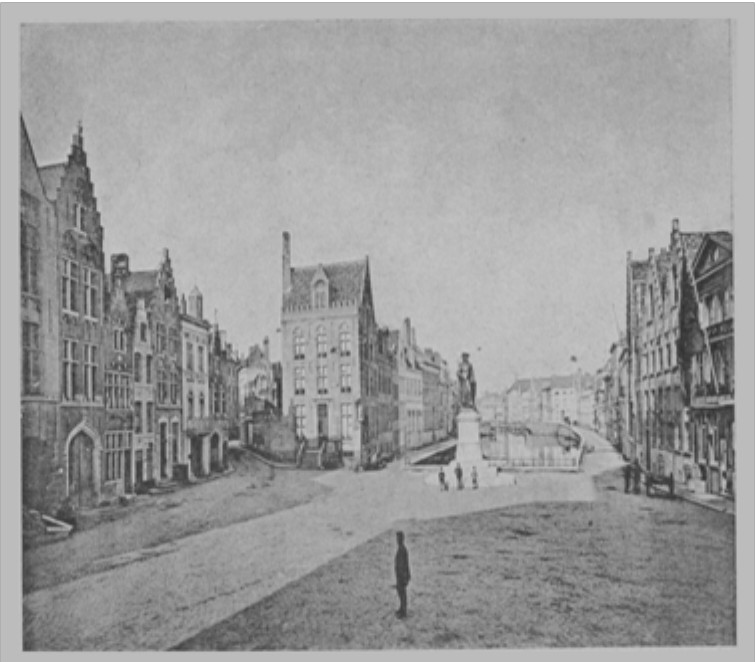
Figure 14. Anonymous. Jan Van Eyck Square in Bruges La Morte (1892)